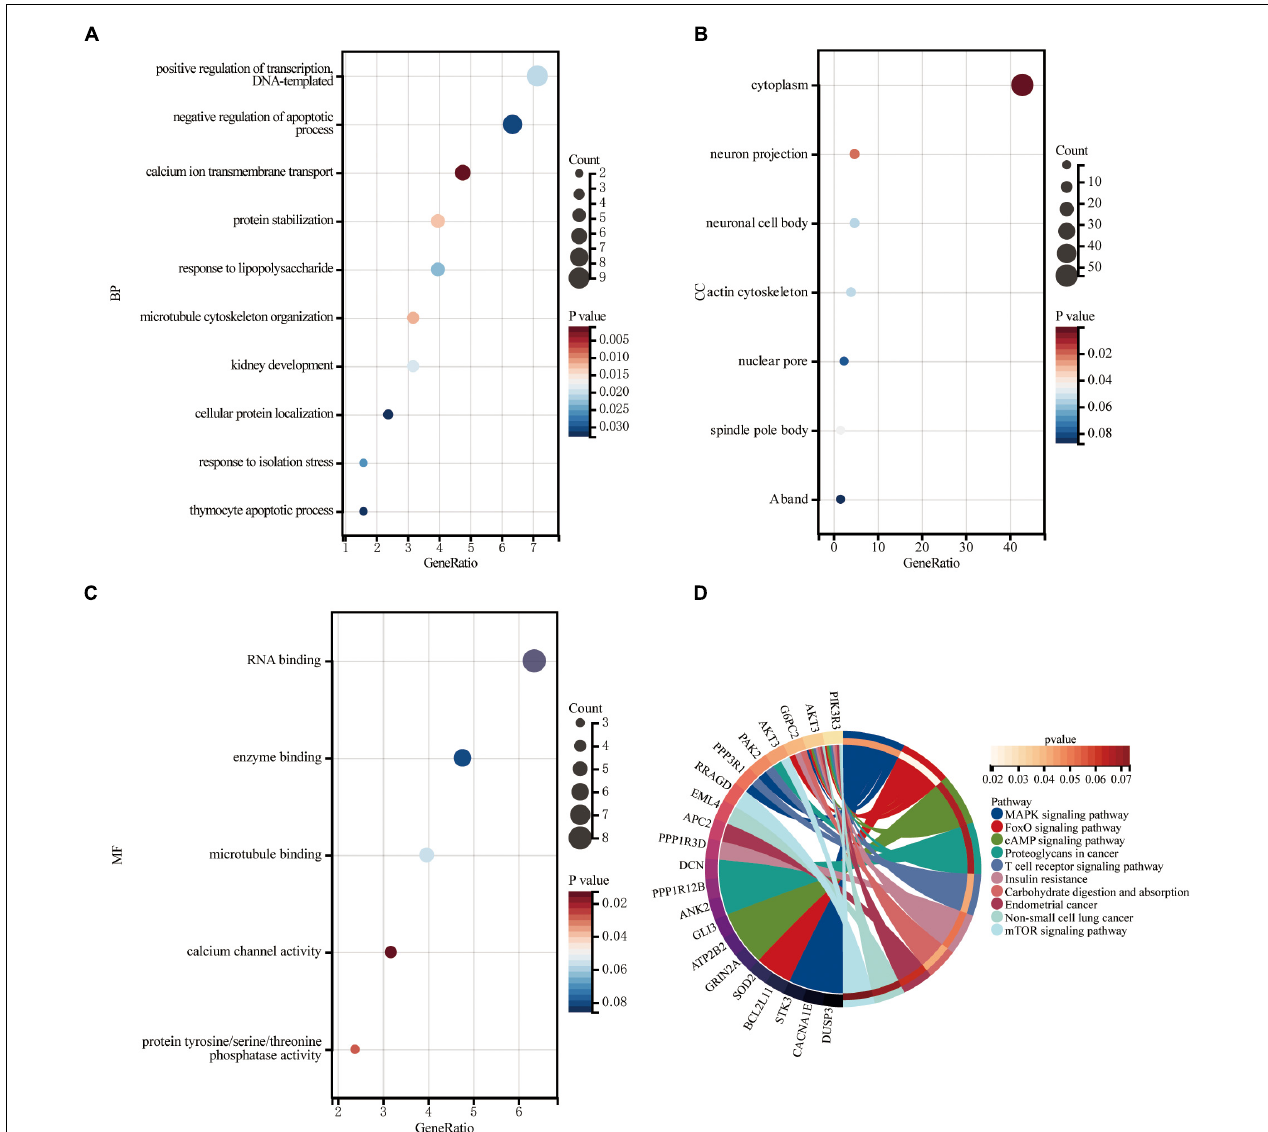
FIGURE 5 | Enrichment of genes in the circRNA-miRNA-mRNA Regulatory Network. (A) Bubble plot of biological process (BP; TOP10). (B) Bubble plot of cellular component (CC; TOP6). (C) Bubble plot of molecular function (MF; TOP5). (D) Circle plot of KEGG pathway enrichment analysis